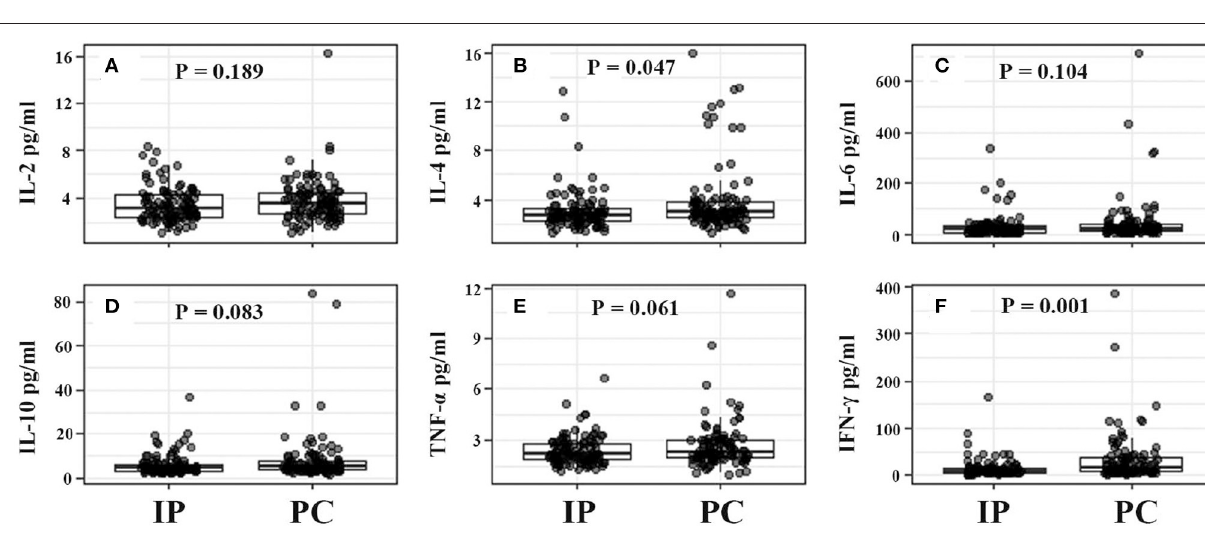
FIGURE 3 | Serum cytokine levels from IP and PC children. (A–F) Were for comparison between IP and PC children after PSA. IFN, interferon; IP, interstitial pneumonia; PC, pulmonary consolidation; PSA, propensity score analysis; TNF, tumor necrosis